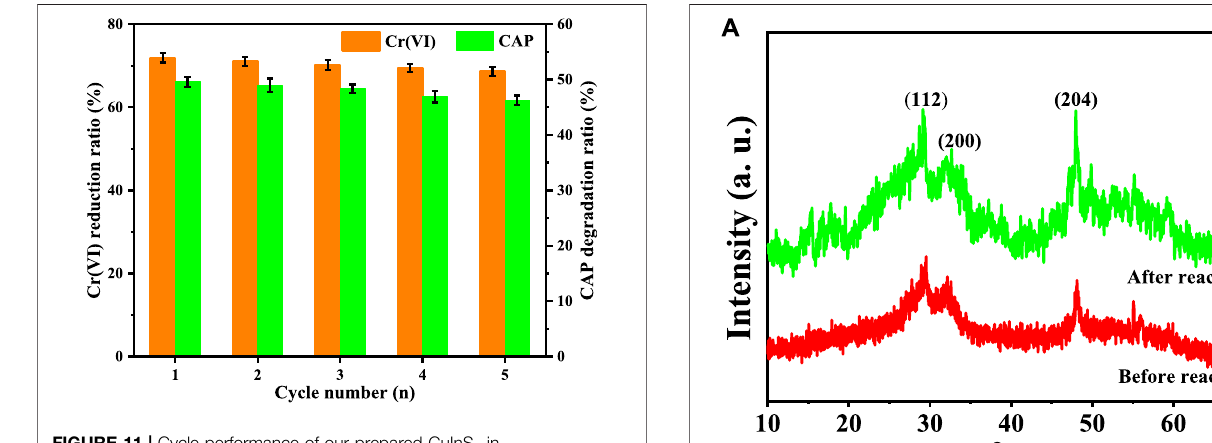
FIGURE 11 | Cycle performance of our prepared CuInS 2 in photocatalytic Cr(VI) reduction and CAP degradation in the Cr(VI)/CAP mixed solution. ([Cr(VI)] = 10 mg/L, [CAP] = 10 mg/L, [catalyst] = 0.2 g/L, pH = 3.0).